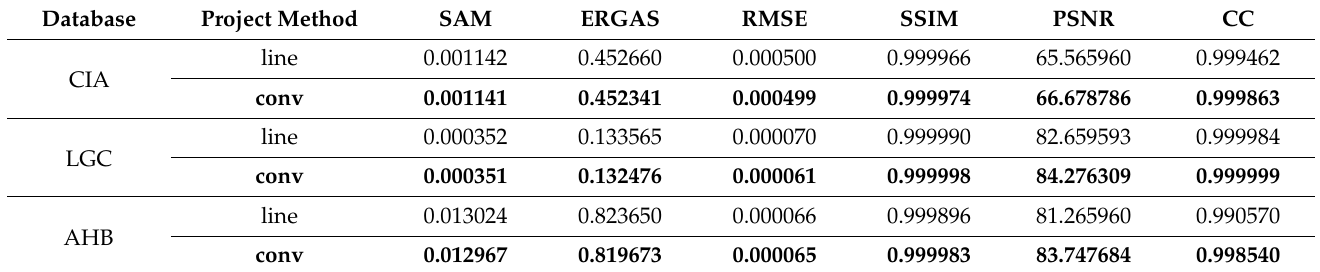
Table 5. Average evaluation values of ICTEs of various project methods on the three datasets.